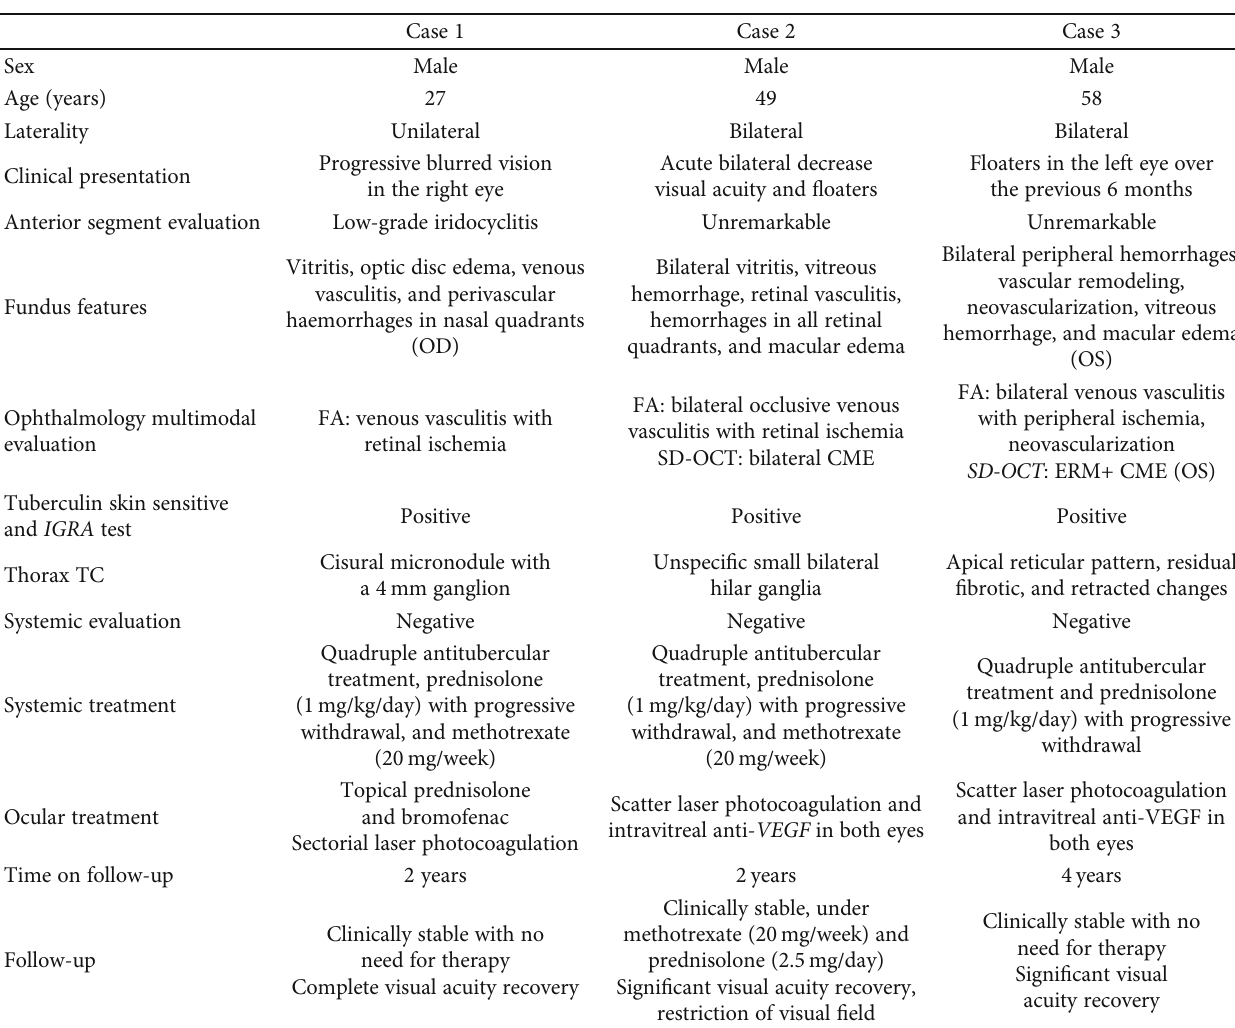
Table 1: Description of the presented cases. Abbreviations: OD: right eye; OS: left eye; FA: fl uorescein angiography; SD-OCT : spectral domain optical coherence tomography; ERM: epiretinal membrane; CME: cystoid macular edema; CT: computed tomography; IGRA: interferon- gamma release assay; VEGF: antivascular endothelial grow